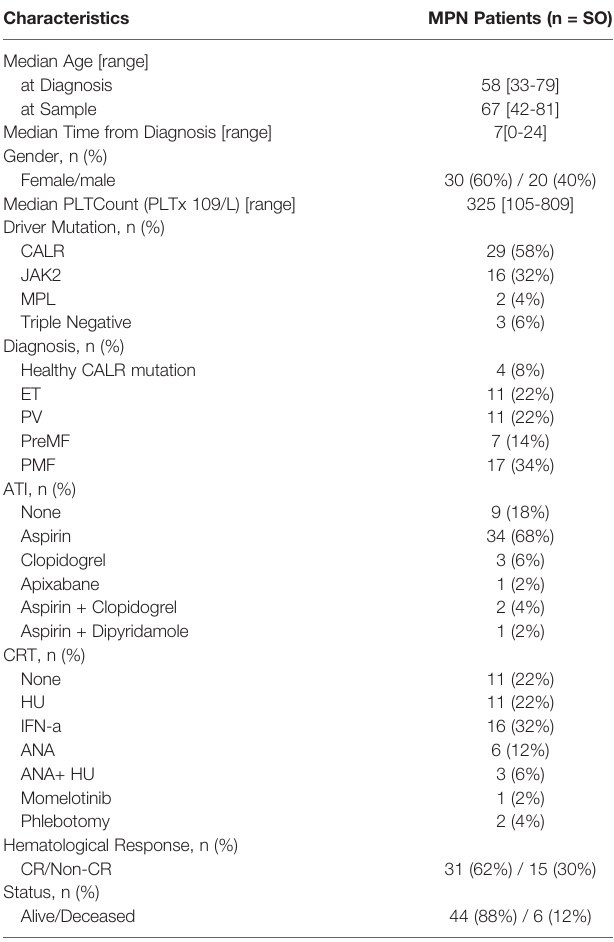
TABLE 1 | Baseline Characteristics of the MPN study population.